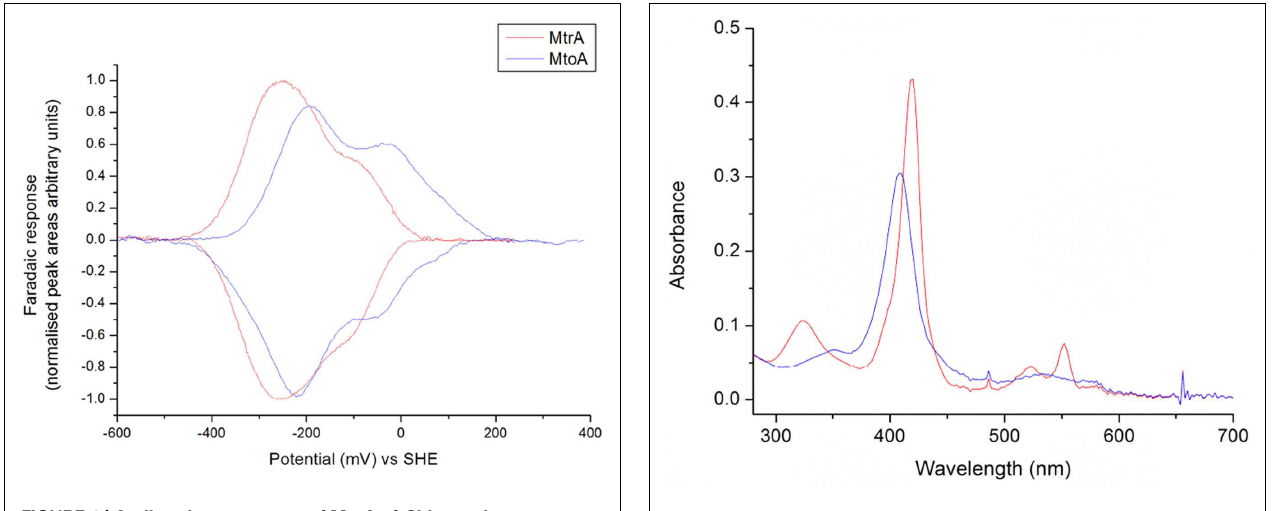
FIGURE 6 |Absorption spectra of MtoA (4 μ M) in 50mM NaCl and 100mM HEPES buffer (pH = 7) in the oxidized (blue line) and the reduced form (red